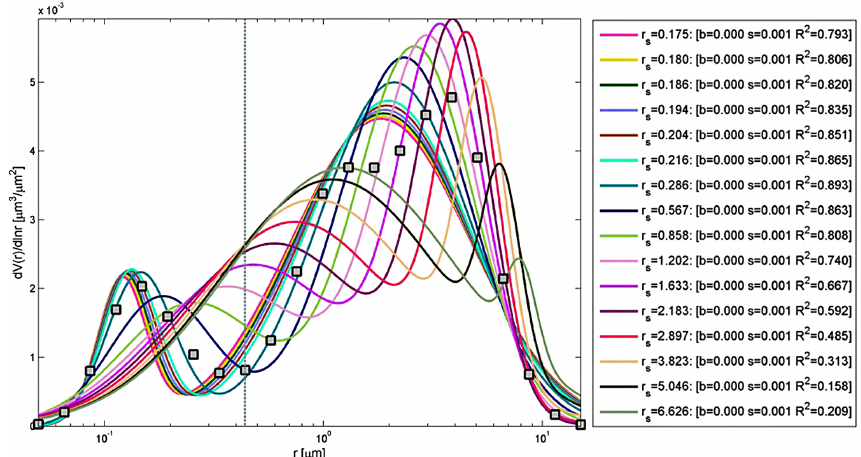
Fig. 2. Sensitivity analysis. The equivalent volume bi-lognormal fit to the AERONET AVSD data obtained by varying the mode separation point rs over a coarse 16-point radial grid spanning the interval 0.1 to 7µm for dominant marine (sea salt) aerosol at Lanai, Hawaii, on 21 January 2002. Note that the optimal mode separation point ( r s = 0.303µm) described in Sect. 3.2 is obtained by applying the max( R 2 ) and min( s) methods on the high-resolution interpolation grid of 2198 points. The grey squares are the values of the AERONET AVSD.